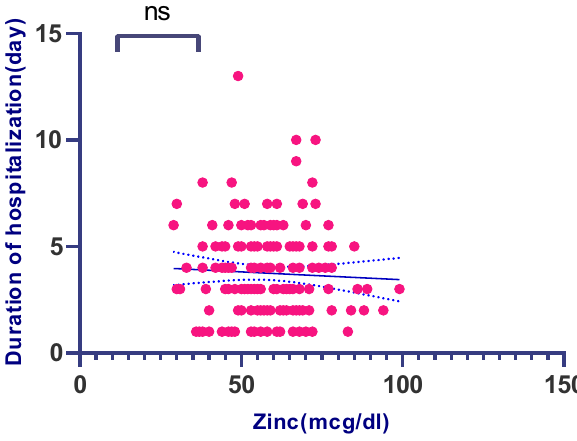
Figure 2: Correlation between serum zinc level and duration of